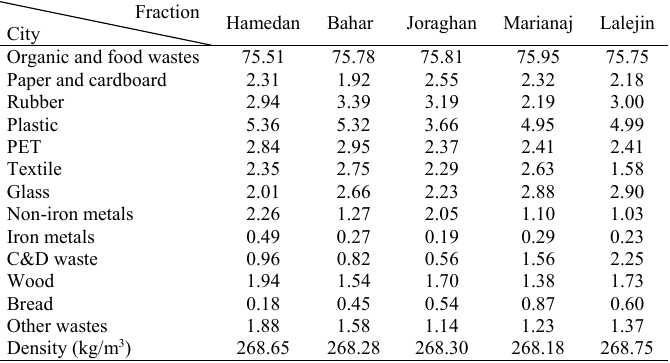
Table 3: Composition of solid wastes in the study area Fraction City